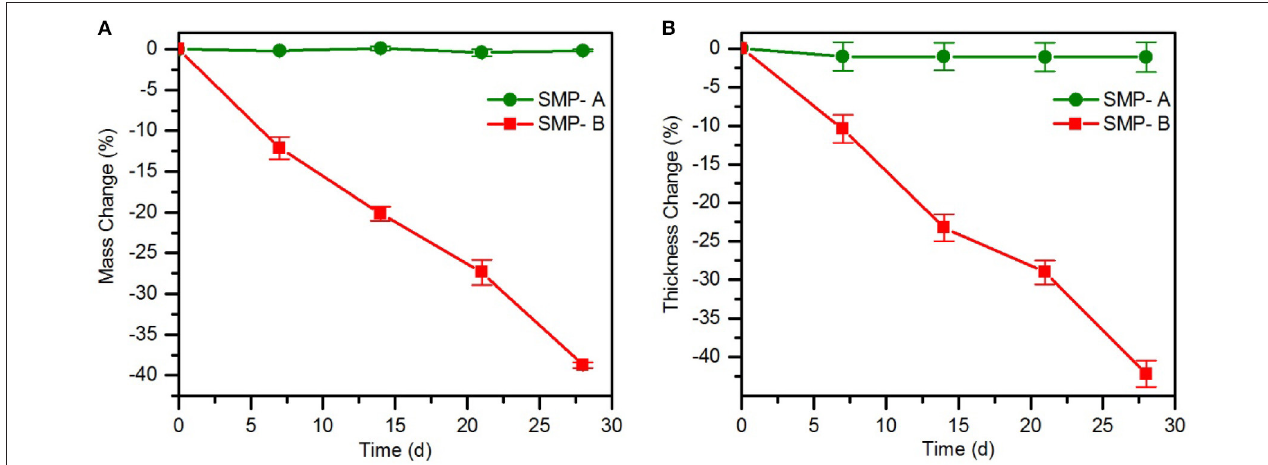
lower onset in the decomposition temperature after 4 weeks in NaOH (from 320 to 300 ◦ C) and even larger shift (from 320 to 250 ◦ C) after 8 weeks in PBS media. Figure 7B displays a more detailed view on the aging effects of 75 ◦ C PBS on SMP- B. The onset of the decomposition temperature shifts